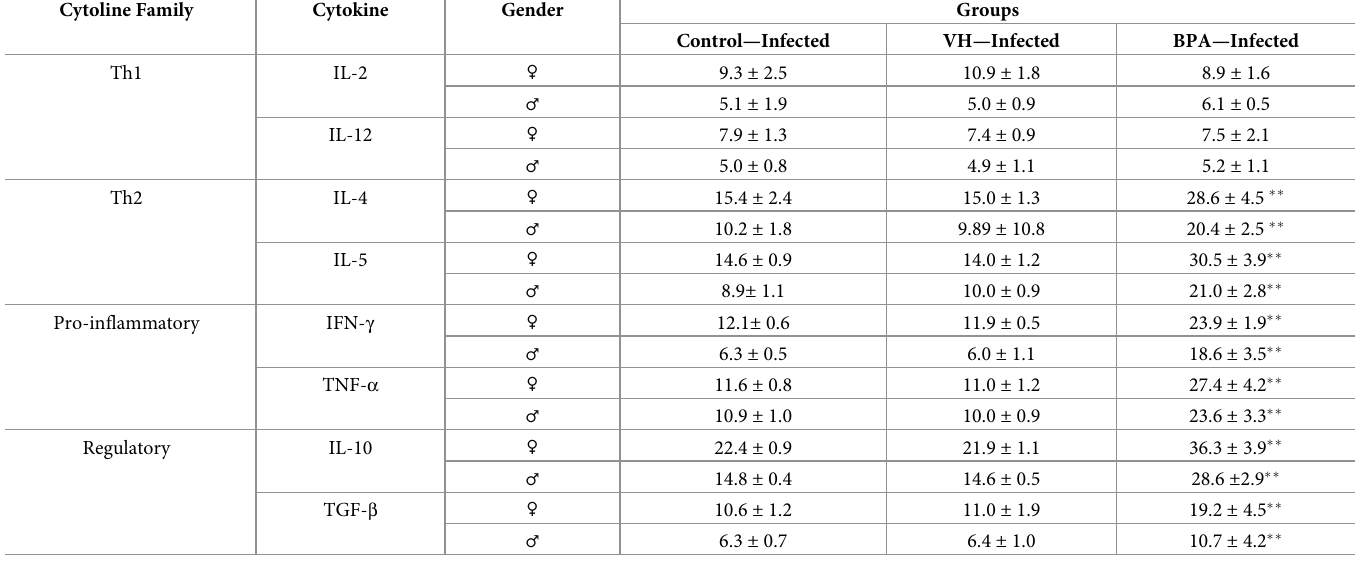
Table 3. Effects of BPA exposure over the cytokine expression pattern in the duodenum of mice infected with Trichinella spiralis .